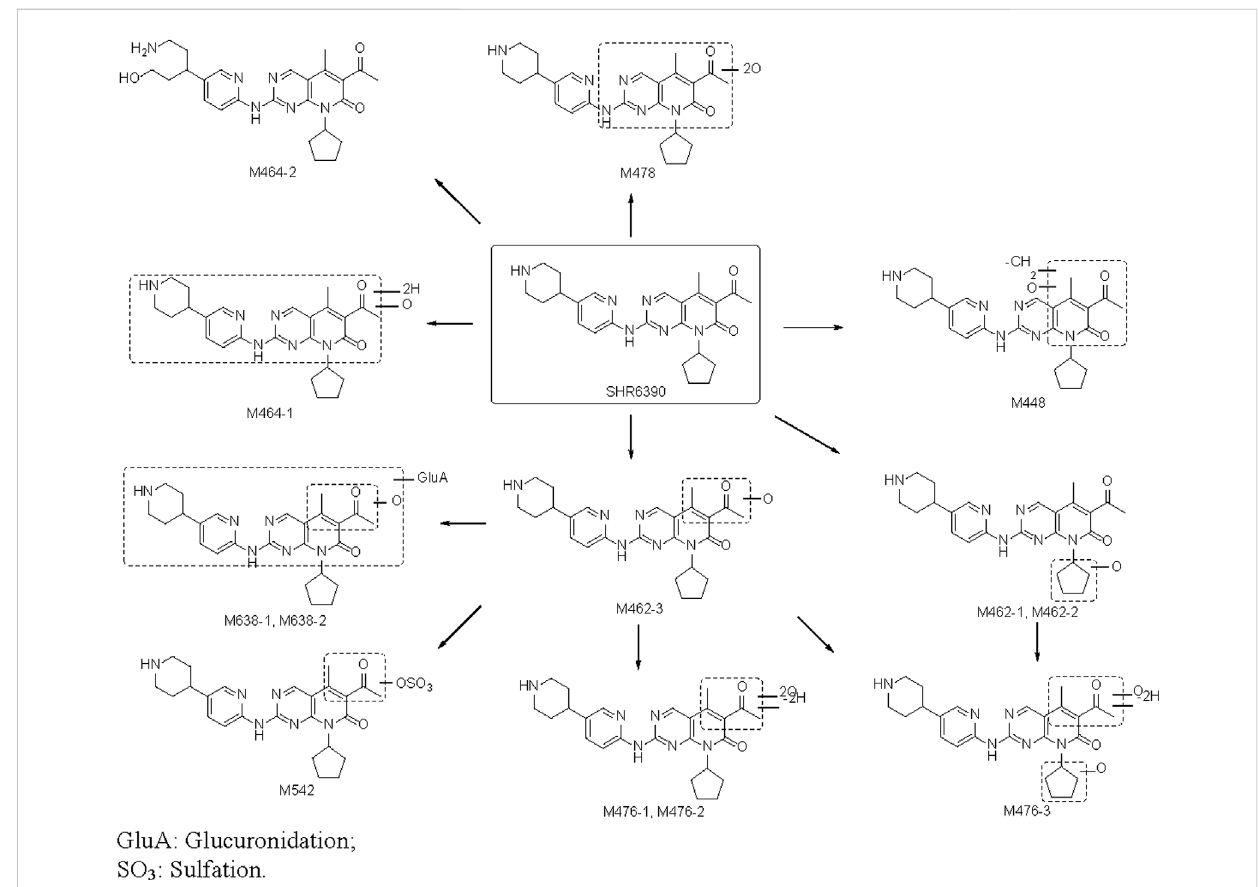
FIGURE 5 Metabolic pathway of SHR6390 in healthy Chinese male